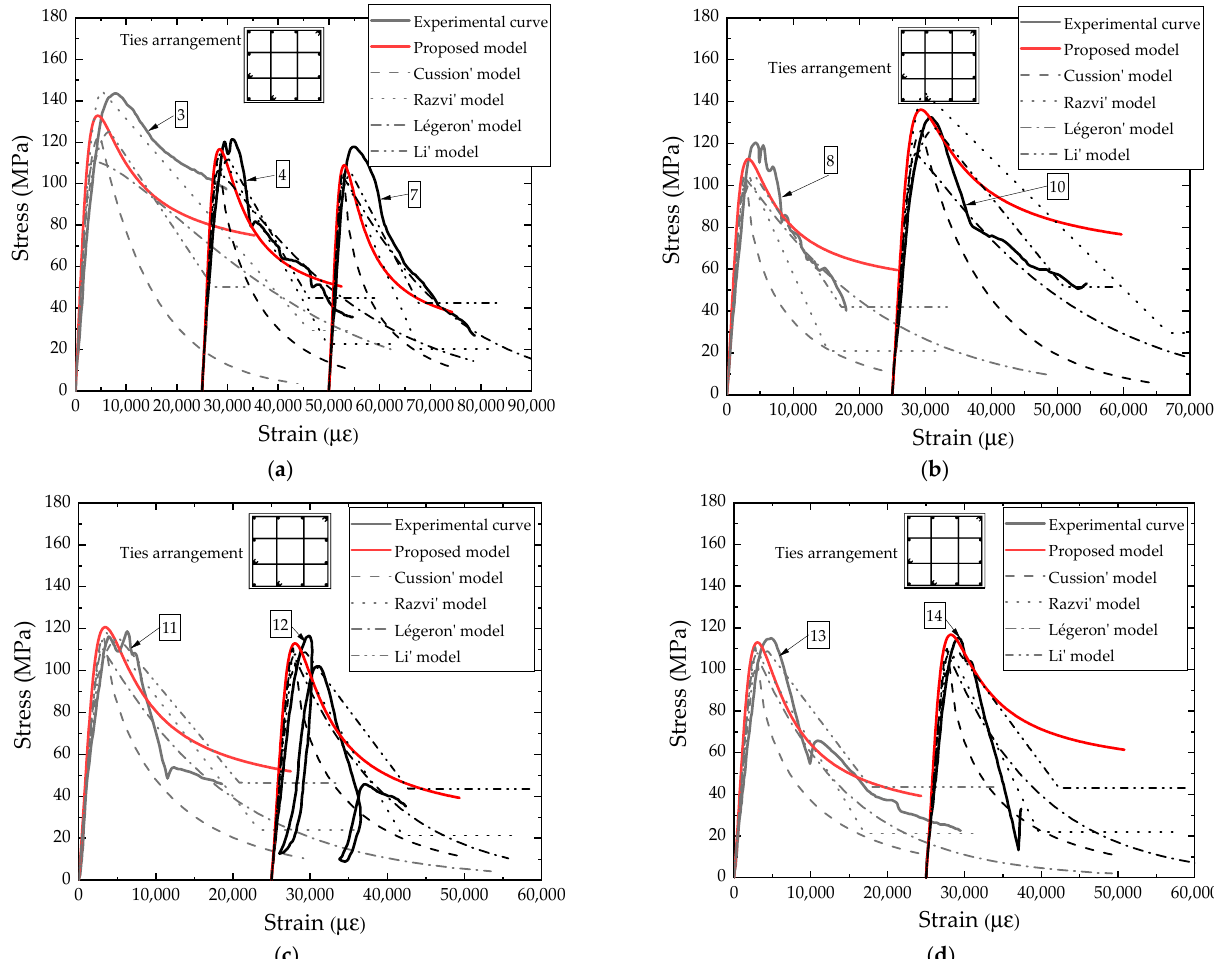
Figure 16. Comparison of experimental curves and analytical models (Nagashima,1992): ( a ) HH08LA and HH10LA; ( b ) HH13LA and HH15LA; ( c ) HH20LA and HL06LA; ( d ) HL08LA.